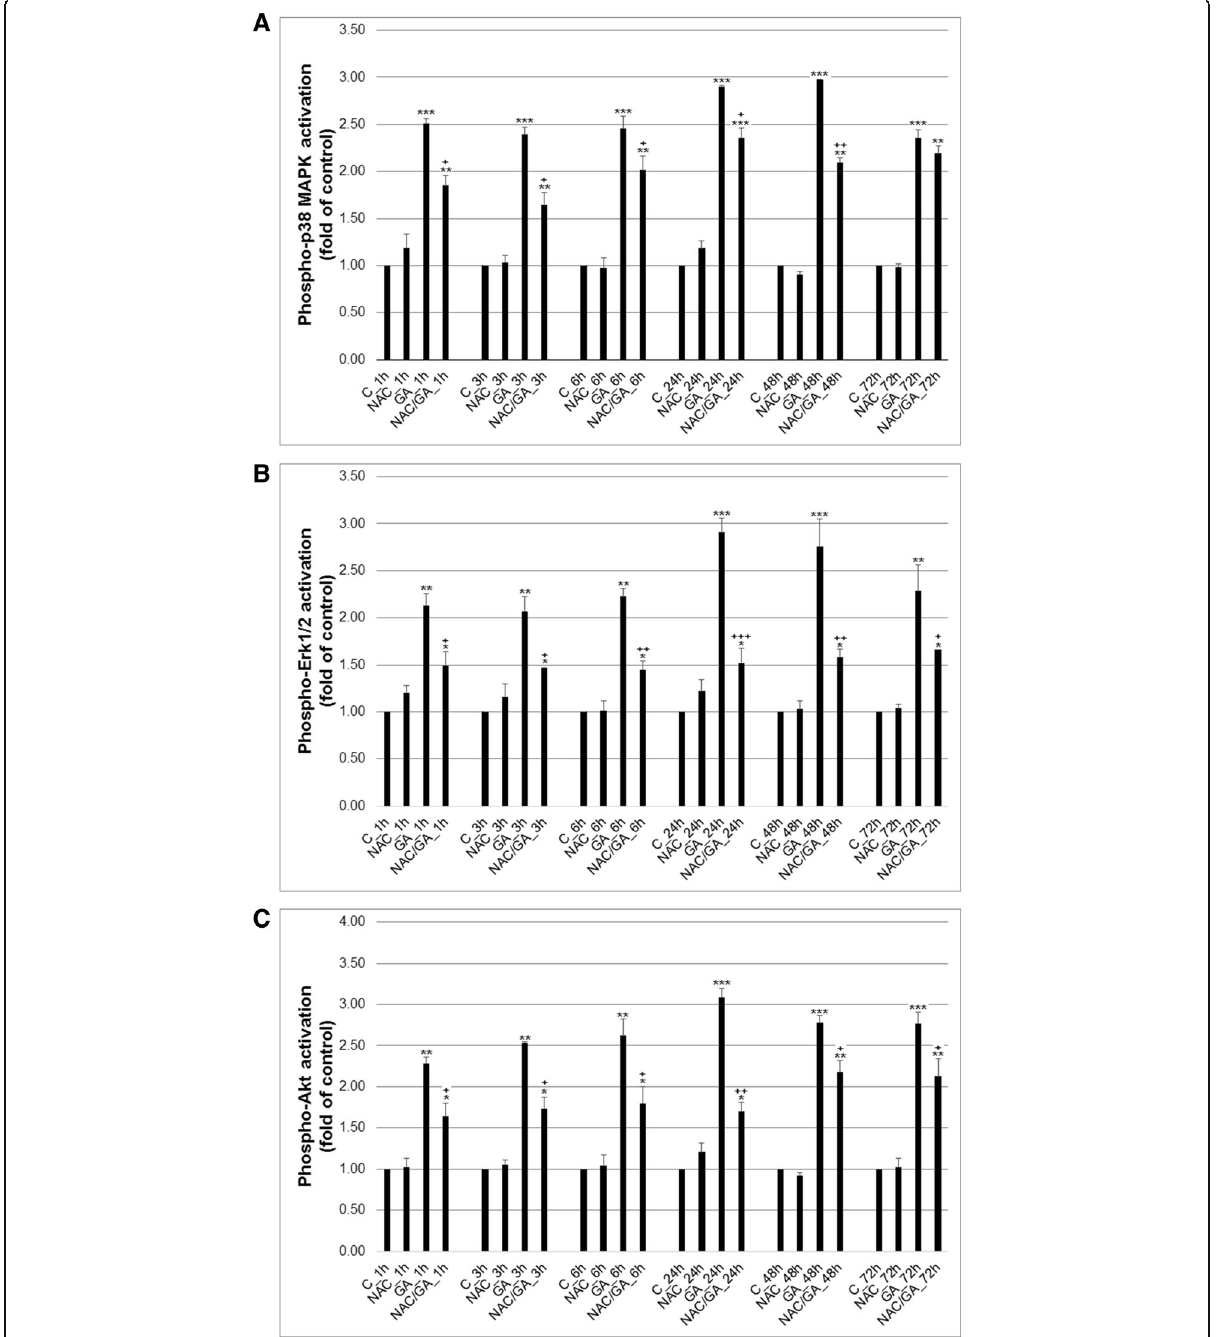
Fig. 6 Effect of GA alone or after NAC pre-treatment on phosphorylation status of signal proteins p38 MAPK ( a ), Erk 1/2 ( b ) and Akt ( c ) in Hela cells. Data were obtained from three independent flow cytometry experiments after 1 – 72 h GA treatment. Significance: * P < 0.05, ** P < 0.01, *** P < 0.001 versus untreated cells (control); + P < 0.05, ++ P < 0.01, +++ P < 0.001 versus